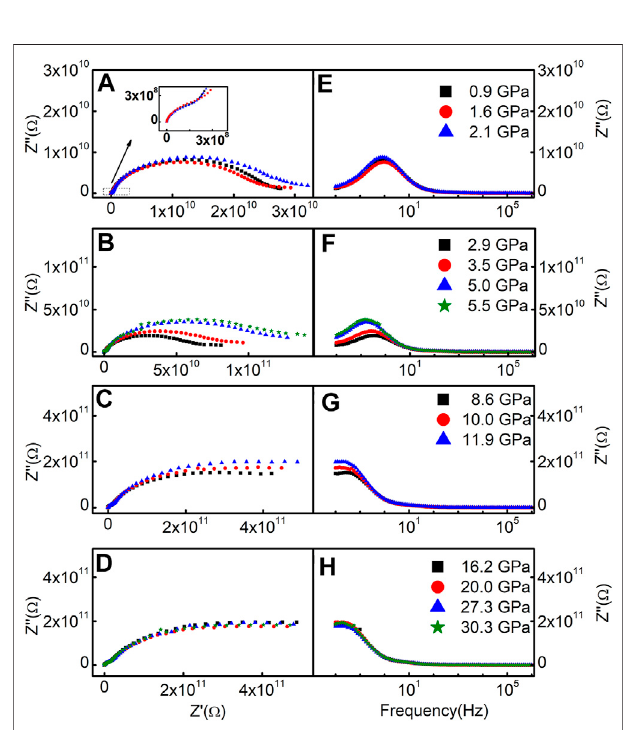
FIGURE 2 | Nyquist ( Z ″ - Z ′ ) plots (A – D) and Z ″ - f plots (E – H) of the impedance data of phenanthrene under different pressures. Inset: the enlargement of the left